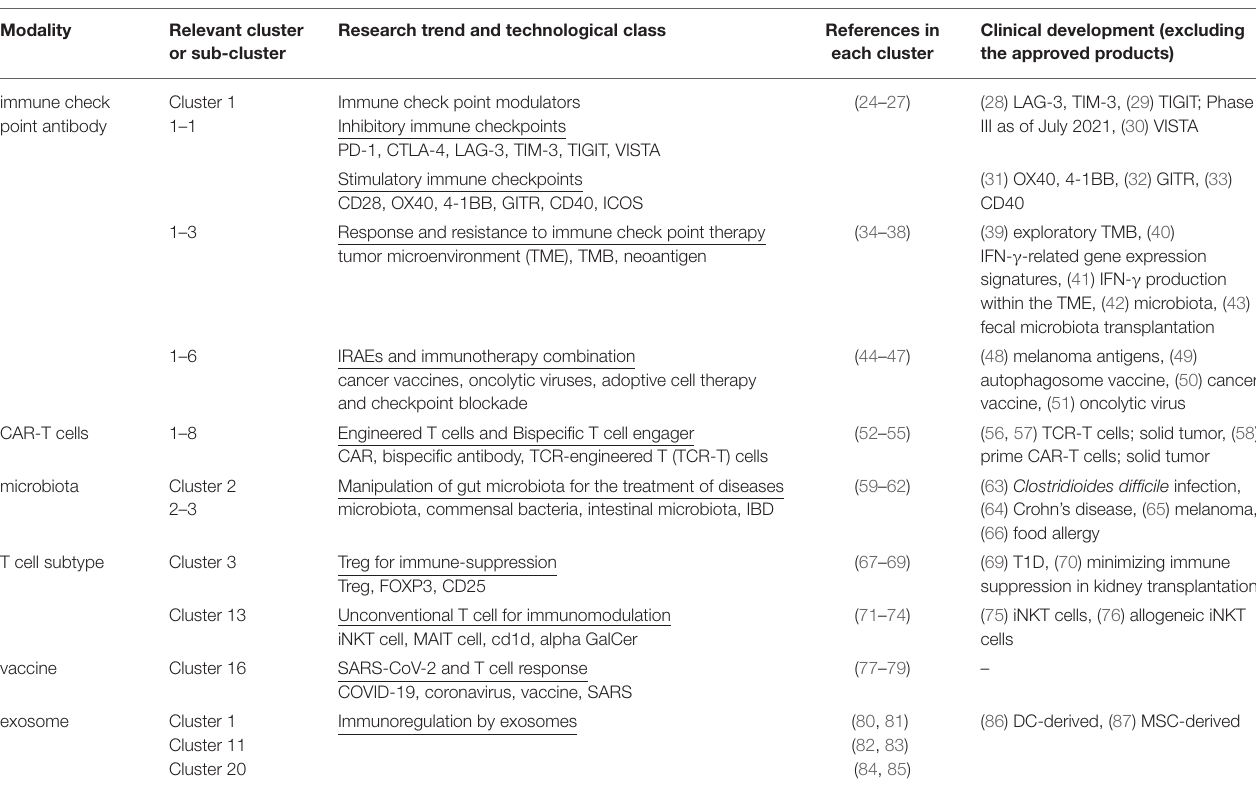
TABLE 2 | Research trends in each cluster.